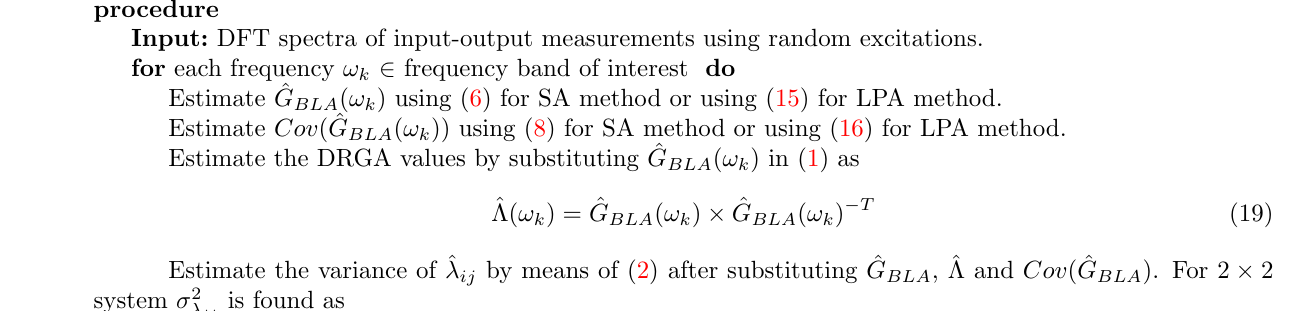
Algorithm 1 Estimation of the DRGA and its uncertainty bounds in the frequency band of interest procedure